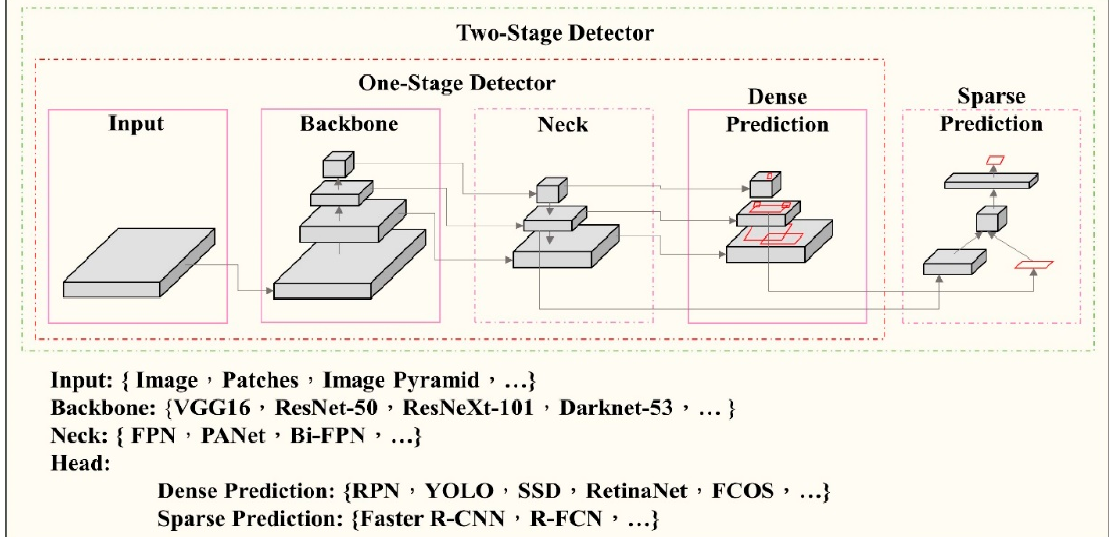
Figure 2. Object-detection